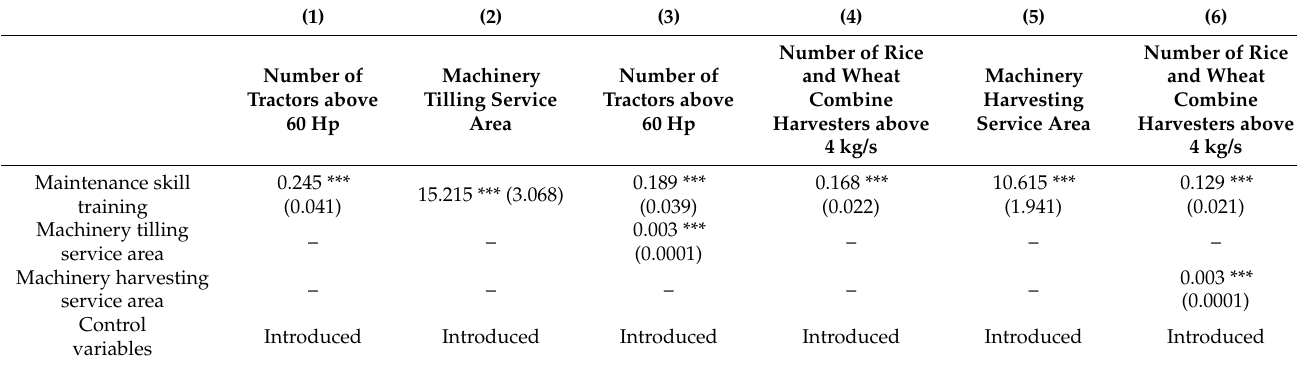
Table 8. Results of mediating effect test with stepwise method.